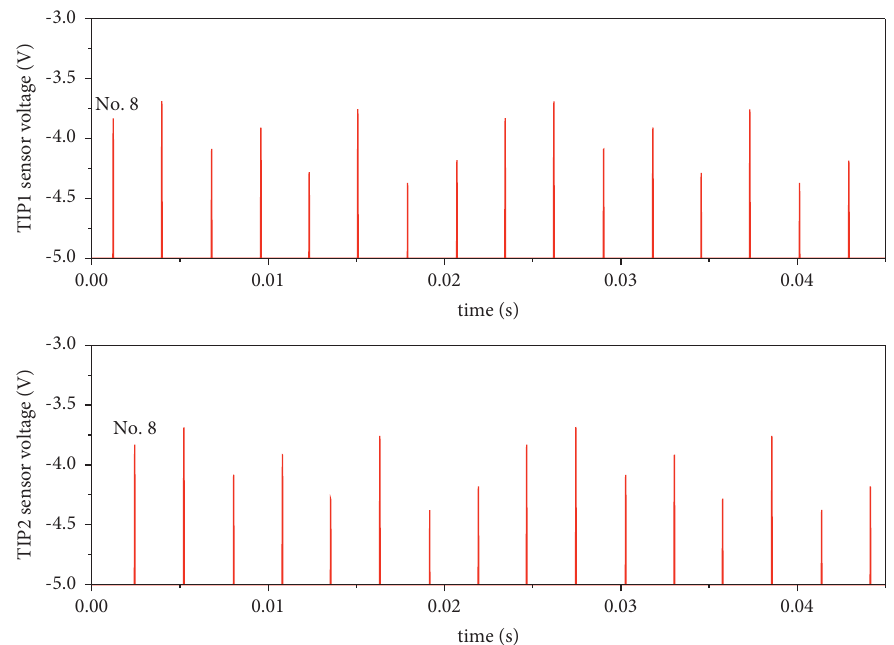
Figure 8: Measurement result of the blade tip-timing sensors under resonance condition.